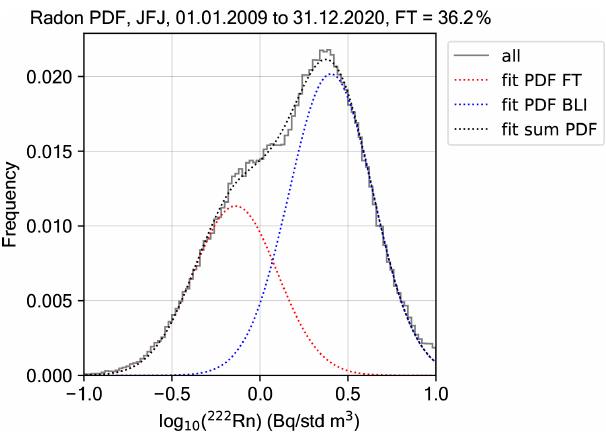
Figure 3. Frequency distribution of radon-222 ( 222 Rn) concentra- tions at JFJ between 1 January 2009 and 31 December 2020 in solid gray, with two fitted lognormal distributions: one for free tropo- spheric air (FT, red dashed line) and the other one for boundary layer intruded (BLI, dashed blue) air mass, both scaled such that the sum (black dashed line) agrees best with the measured 222 Rn frequency distribution. The fits allow us to assess the probability of a given 222 Rn concentration to be measured within FT air